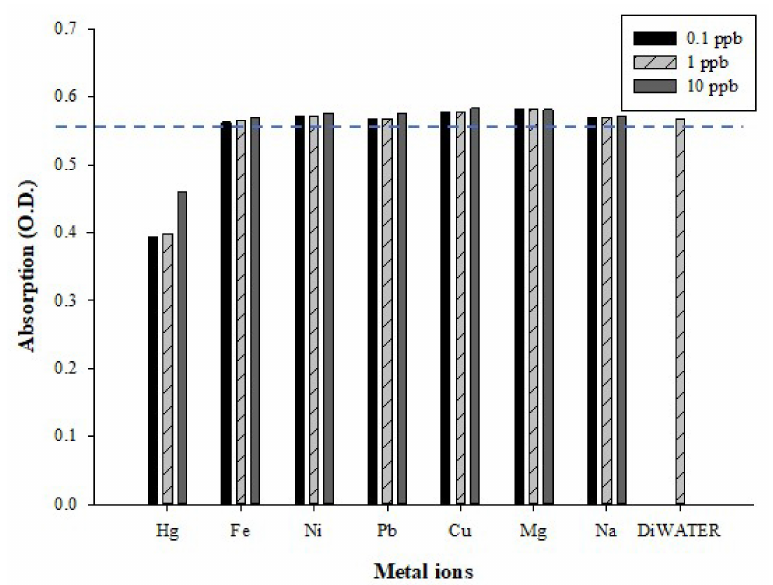
Figure 8. False-positive tests: UV–Vis spectra at a wavelength of 400 nm for AgNPs combined with different metal ions and deionized water (control). The metal ion concentrations were 0.1, 1, and 10 ppb.